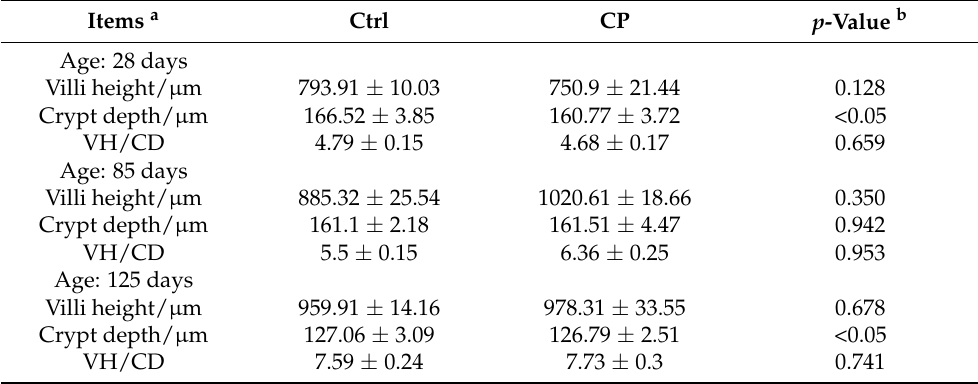
Table 6. Effects of compound probiotics on the morphological structure in the duodenum mucosa of